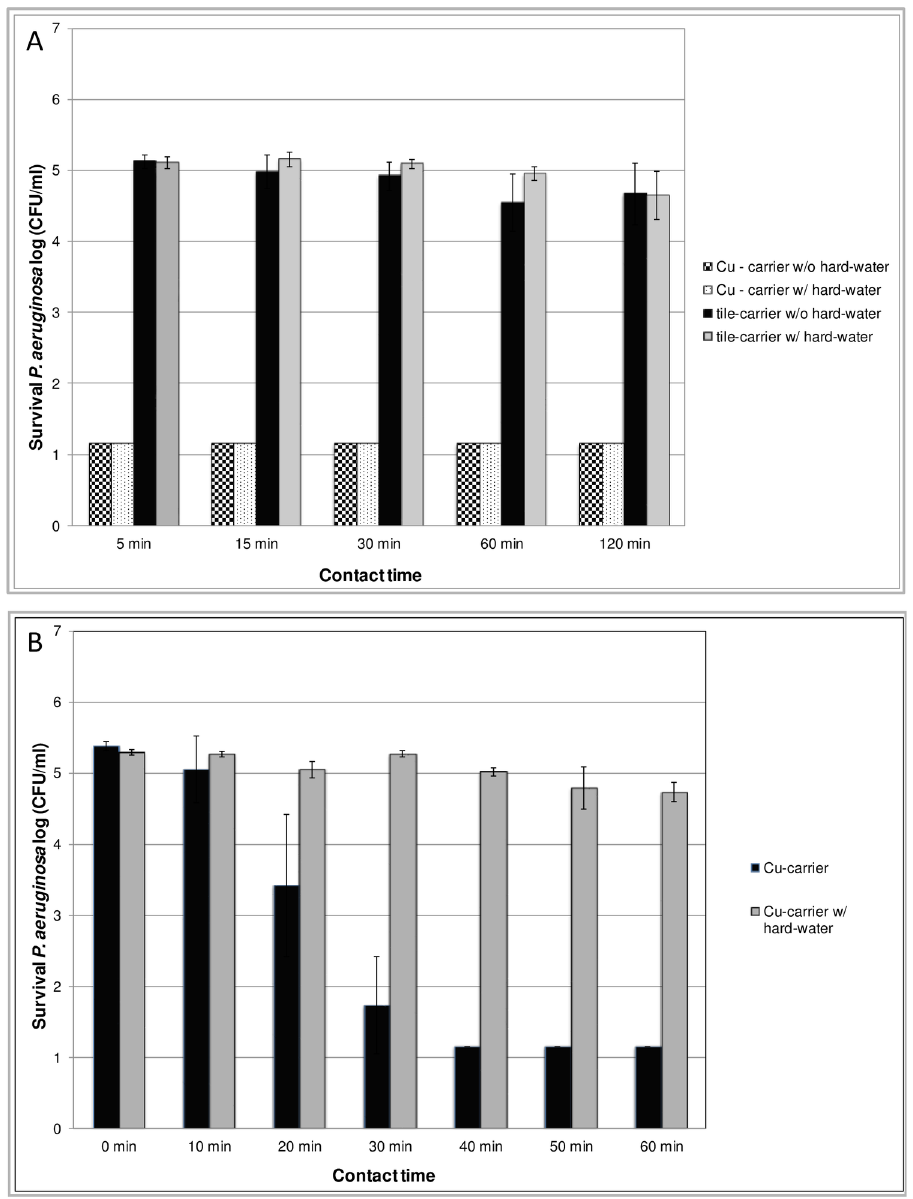
Fig 2. Impact of humidity on survival of P . aeruginosa on copper alloy discs (CuSi21Si3P). A: Carriers were inoculated with 100 μl bacterial suspension of P . aeruginosa (titer: 1.5–5 x 10 7 CFU/ml) in the presence of organic soiling (0.3% BSA; 0.3% sheep erythrocytes). After drying for max 60 min, 200 μl standardized hard-water was added to the samples indicated as “w/ hard-water”. Samples indicated as “w/o hard-water” received no addition of standardized hard-water. Microbial survival rates were determined at the intervals indicated in Material and Methods and expressed as log CFU/ml. The design of the experiments is depicted schematically in S1 Fig. B: Copper alloy discs were inoculated with 100 μl bacterial suspension of P . aeruginosa (titer: 1.5–5 x 10 7 CFU/ml) in the presence of organic soiling (0.3% BSA; 0.3% sheep erythrocytes). Immediately after inoculation, 200 μl standardized hard-water was added exclusively to the samples indicated as “w/ hard-water”. Microbial survival rates were determined as described in Material and Methods at the intervals indicated and expressed as log CFU/ml. The experiments were repeated at least three times on different days. Mean values are displayed with standard error. The design of the experiments is depicted schematically in S2 Fig.